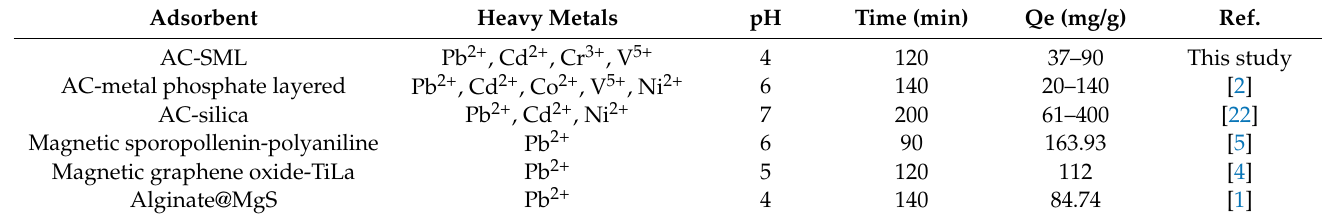
Table 3. Comparison of AC-SML with other published adsorbents for heavy metal